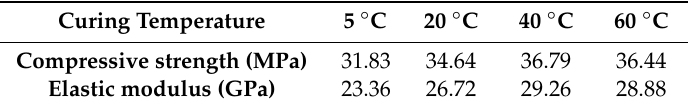
Table 2. Mechanical properties of concrete under di ff erent temperature at 28 d.